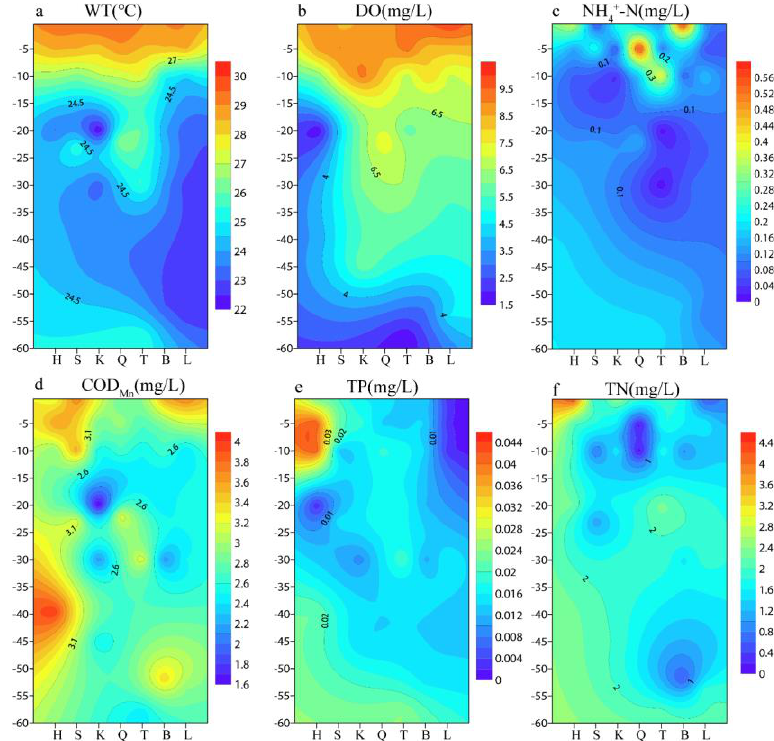
Figure 3. Variation of vertical physicochemical parameters in the Danjiangkou Reservoir (( a ) WT; ( b ) DO; ( c ) NH 4+ -N; ( d ) COD Mn ; ( e ) TP; ( f ) TN).